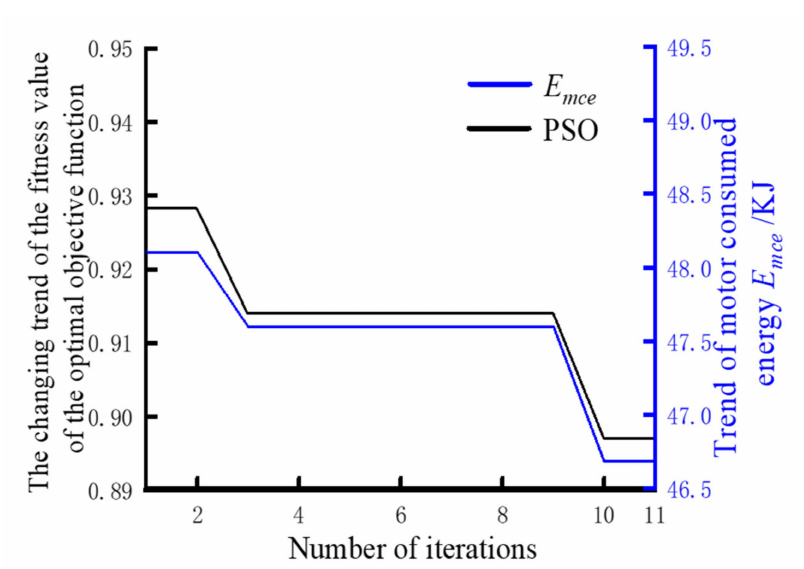
Figure 20. The changing trend of the fitness value of the optimal objective function and motor energy